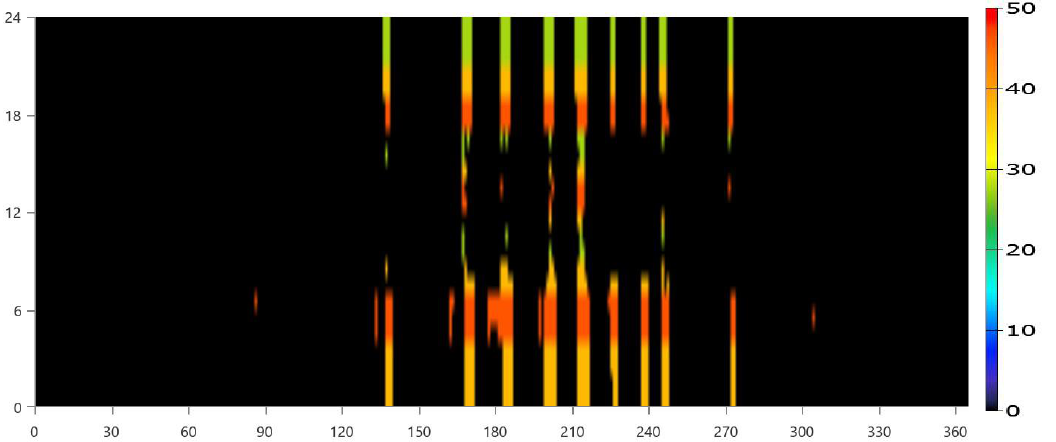
Energies 2022 , 15 , x FOR PEER REVIEW Figure 11. Diesel Consumption (L/hour). Figure 11. Diesel Consumption (L/hour).